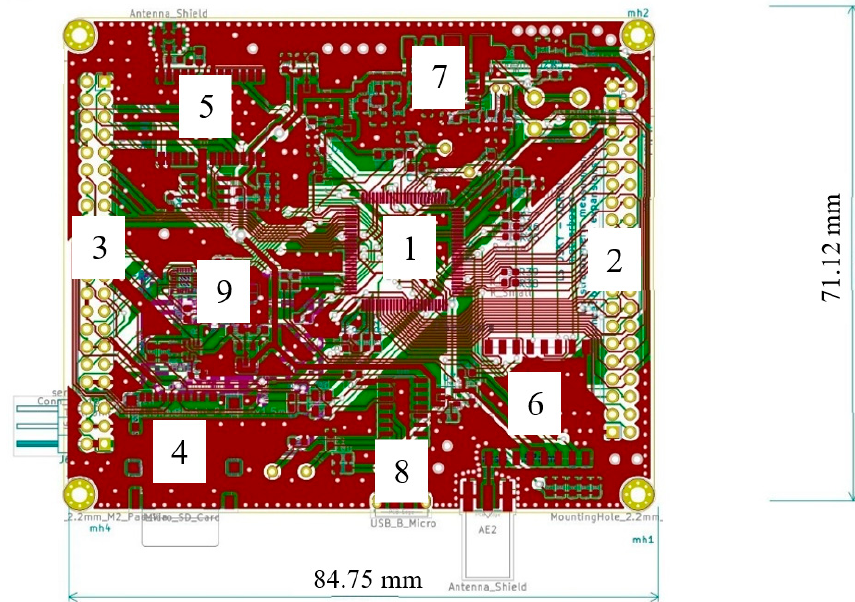
Figure 6. View of the modified version of the integrated circuit board.